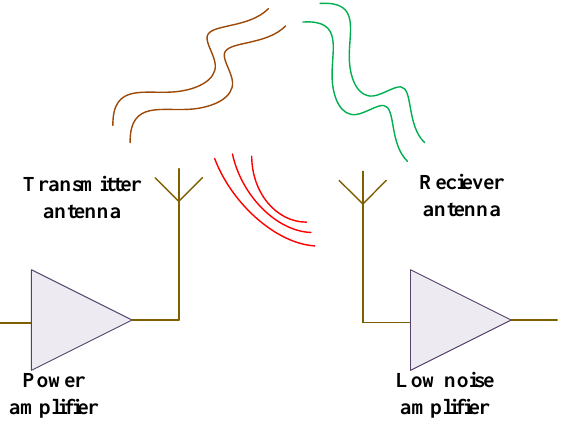
Figure 2. A typical structure of any communication system includes PAs and